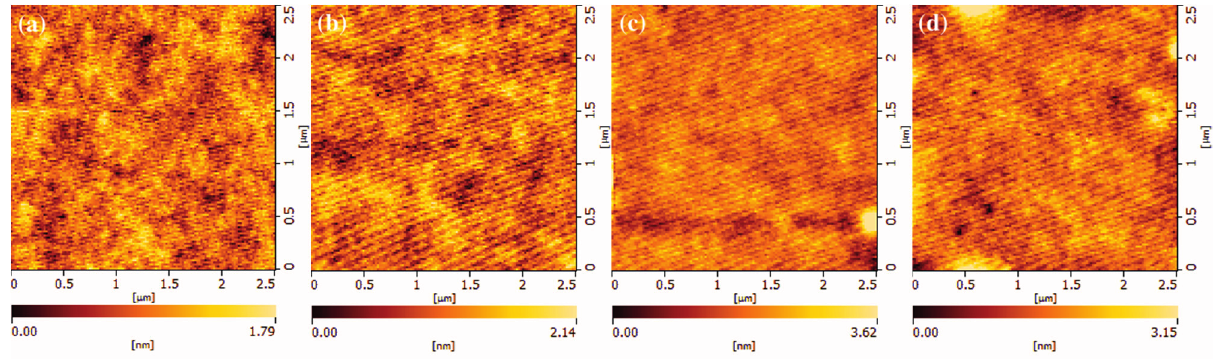
Figure 3. AFM images of ( a ) PTC-U; ( b ) PTC-U-1hr; ( c ) PTC-U-2hr and ( d ) PTC-U-4hr coated on ITO glass. The average RMS roughness of each samples are PTC-U = 1.47 nm, PTC-U-1hr = 1.52 nm, PTC-U-2hr = 1.77 nm, PTC-U-4hr = 1.81